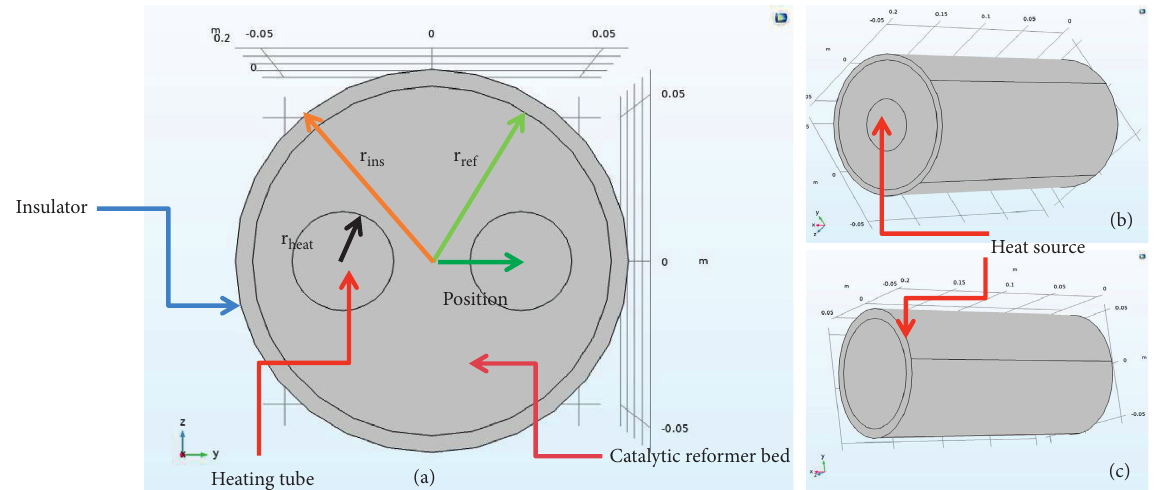
Figure 2: (a) Frontal view of the reactor and schematic of reactors with (b) one heating tube at the center and (c) outer shell-type heating.